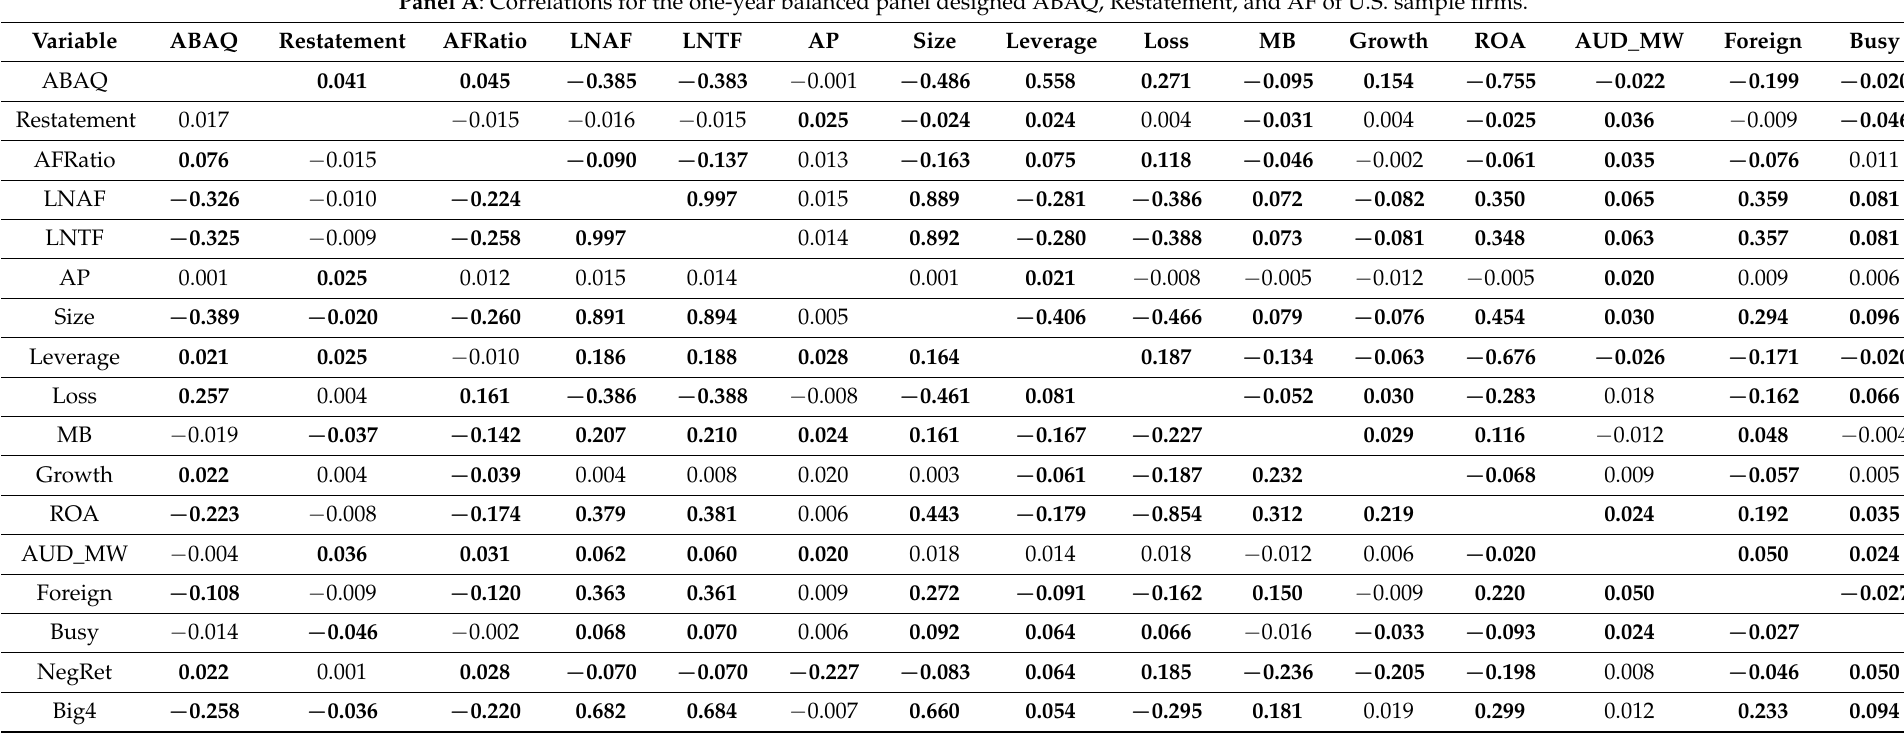
Table 3. Pearson (above the diagonal) and Spearman (below the diagonal) correlations for variables in the regression analyses. Panel A : Correlations for the one-year balanced panel designed ABAQ, Restatement, and AF of U.S. sample